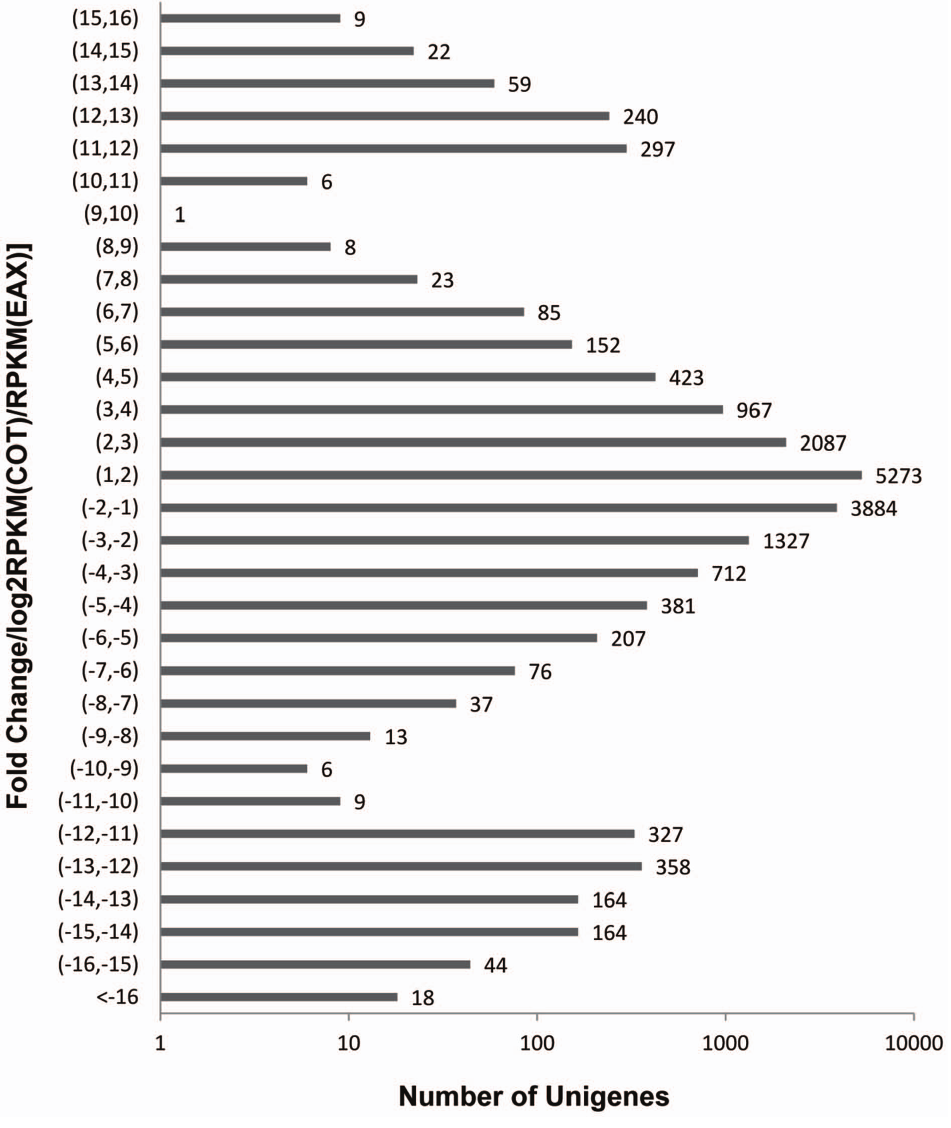
Figure 4. Unigenes that were differentially expressed between cotyledon and embryo axis libraries. Embryo axis abbreviated as EAX, Cotyledon abbreviated as COT, Fold change/EAX/COT (RPKMs) was calculated by the formula: log (RPKM (EAX)/RPKM (COT),